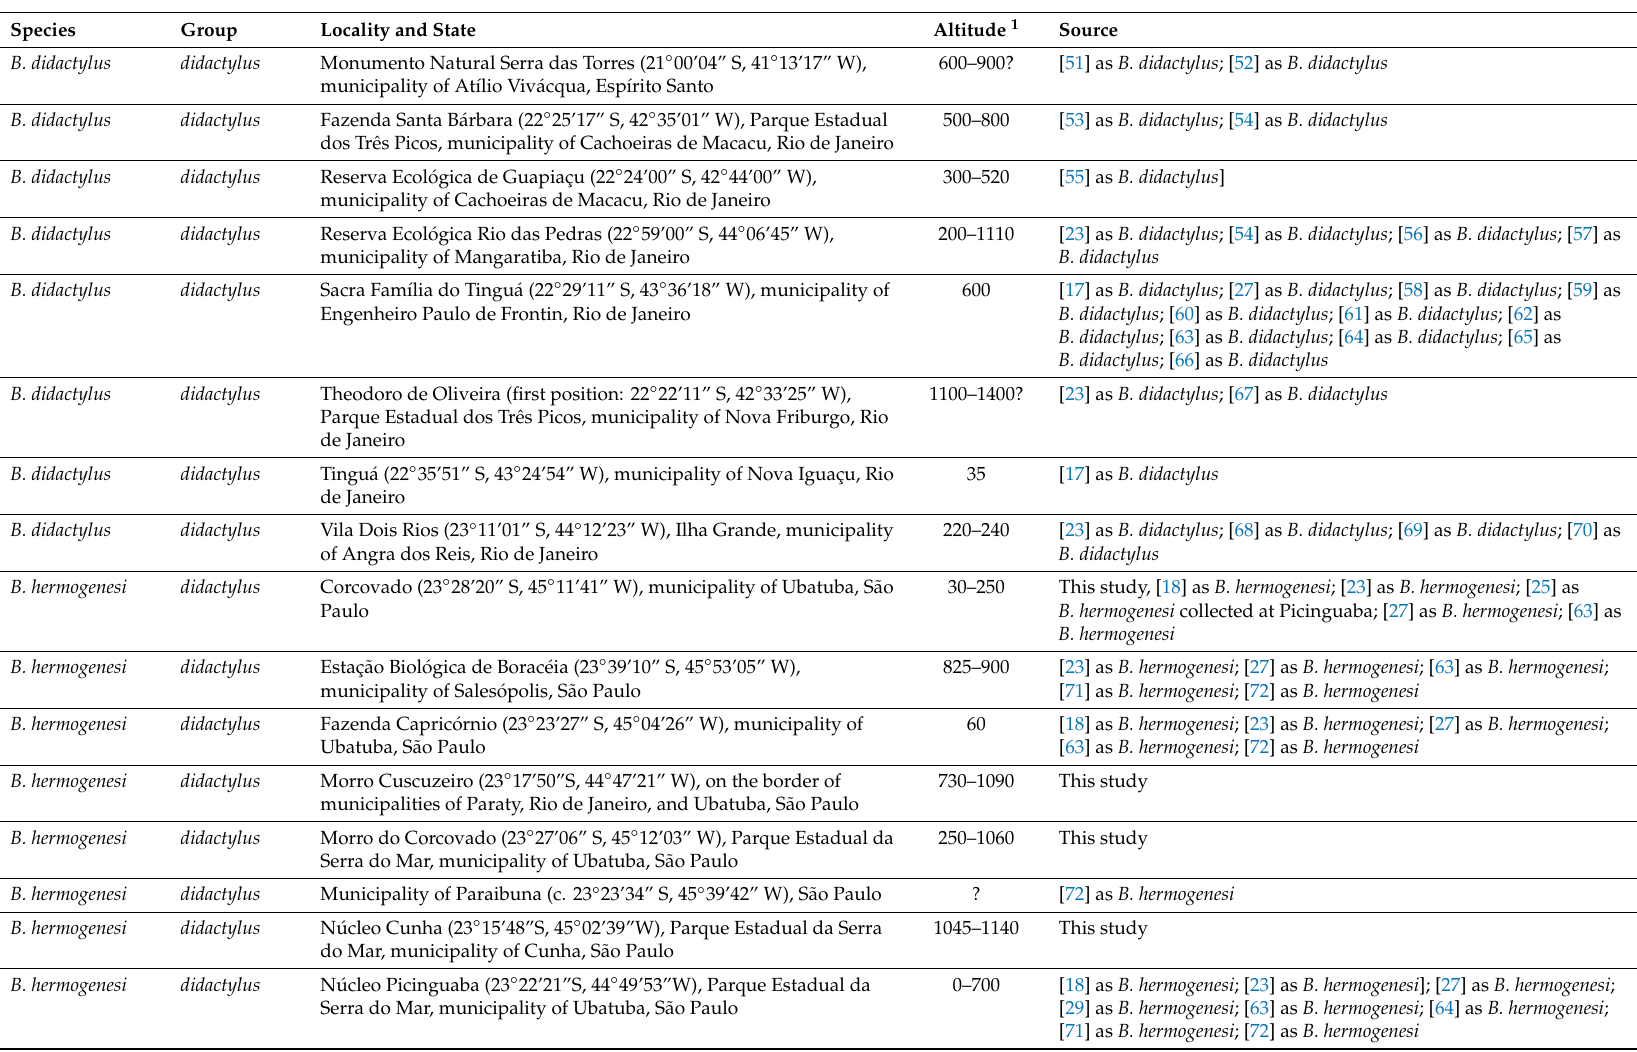
Table 1. Locality records of Brachycephalus